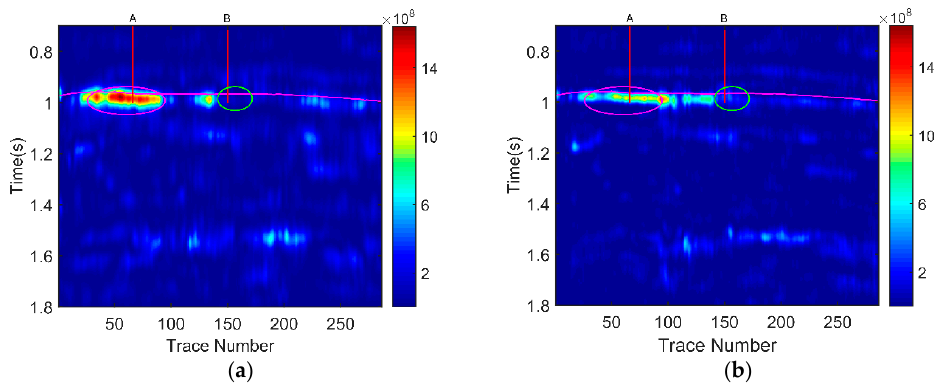
Figure 10. Constant frequency sections based on VMD/CWT/FWEO: ( a ) at 31 Hz; and ( b ) at 43 Hz.